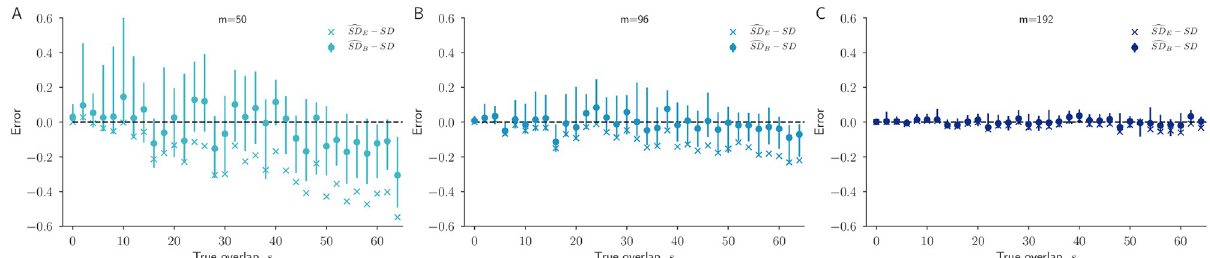
Fig 5. Bayesian vs empirical Sorensen-Dice estimates. For each overlap value s between 0 and 70, we performed one independent simulation to generate synthetic count data (Methods) and estimated the Sorensen-Dice coefficient using estimates from our Bayesian framework as well as from the raw empirical data. The error in the Bayesian Sorensen-Dice estimate, c SD (Eq (15)), and accompanying 95% credible intervals are shown. The often- B used empirical Sorensen-Dice estimate, c SD (Eq (14)), is also shown. The dashed black line at 0 represents the true Sorensen-Dice coefficient (Eq (13)). E